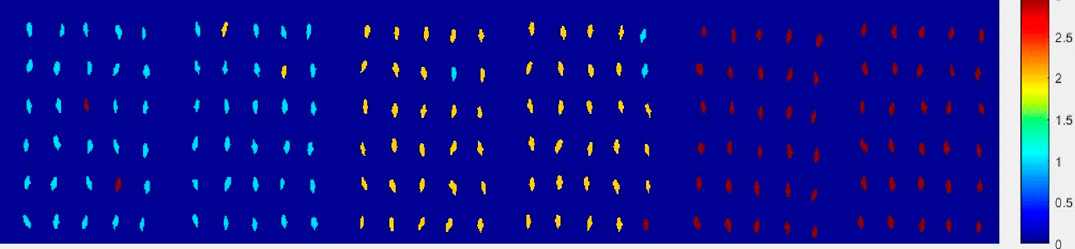
Figure 9. The final visualization images of Haoyu21 with the SPA and PLS-DA model with method M2P.